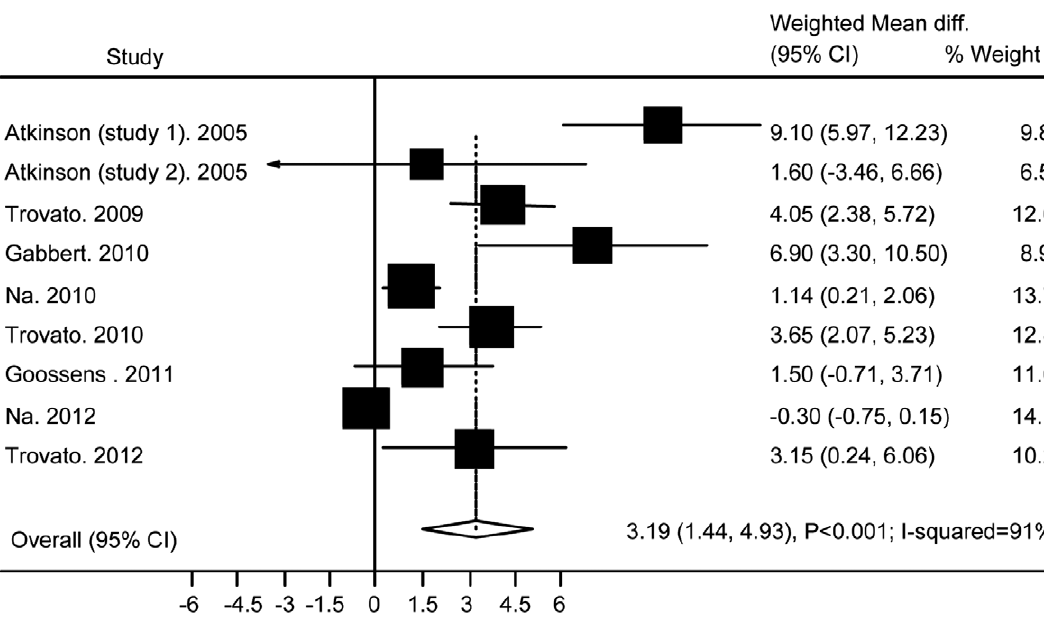
Figure 2. Association of Ad36 with BMI.